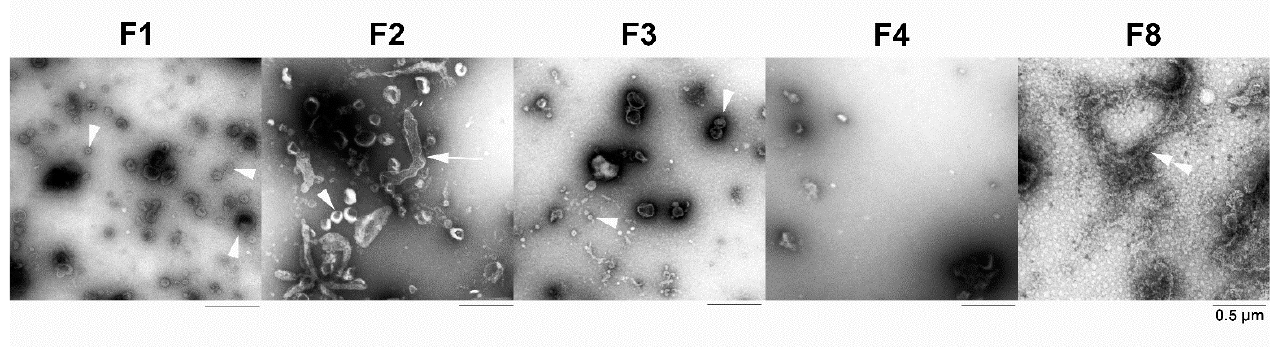
Figure 6. Ultrastructural analyses of the subcellular fractions by negative staining with uranyl acetate. In the negatively stained F1, predominantly round vesicles (arrowheads) with a size of 150 to 250 nm were observed. Endolysosomes typically have an in situ size between 200 nm and >1 µm ([24] see also Section 3.5) but the preparation of F1 likely leads to the shrinking of these organelles. In F2, vesicles (arrowhead) with various diameters from 50 nm to 250 nm and some tubular membranes (arrow) could be recognized. In F3, the different sized vesicular structures were mixed with small protein aggregates, which were diminished in F4. In F8, which was included as a negative control, a tubular network (double arrowhead) was predominantly present. The dark areas in the micrographs are due to higher amounts of uranyl acetate (see Methods).